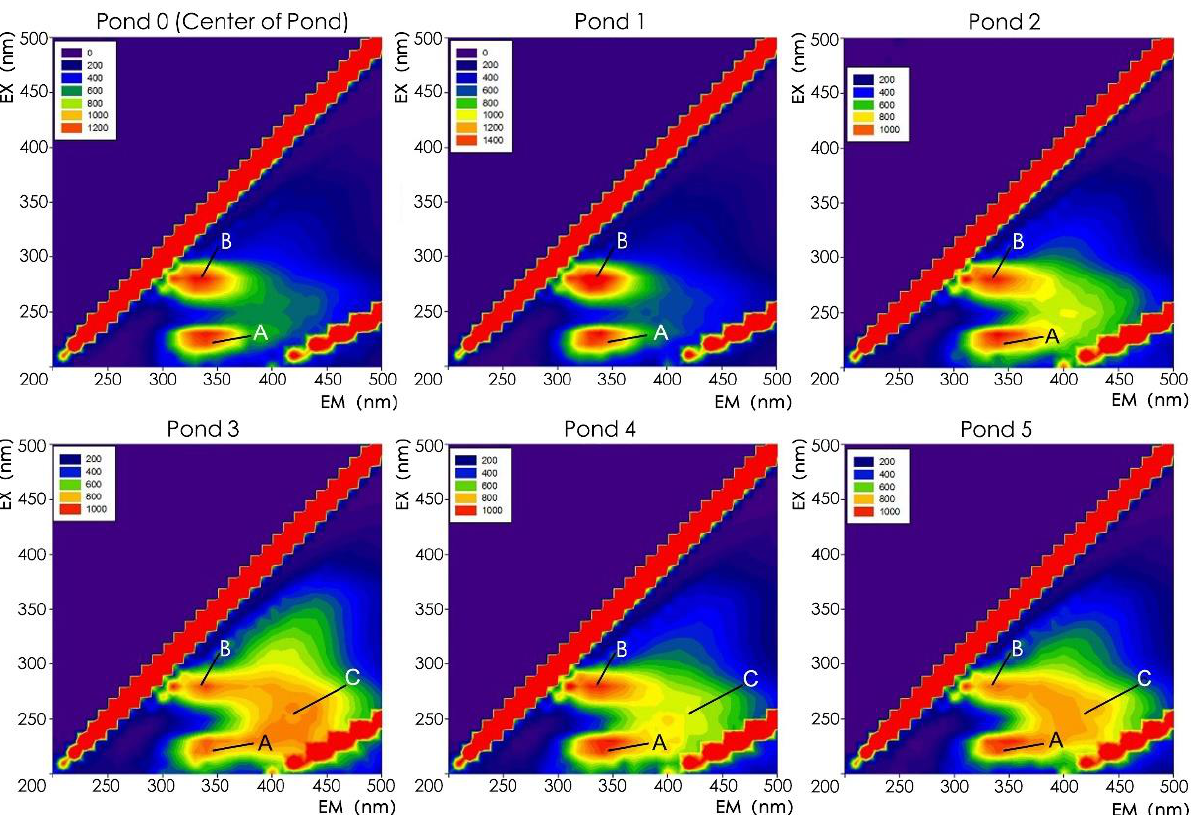
Figure 8. The 3DEEMFS of each pond in September of the third experimental year.